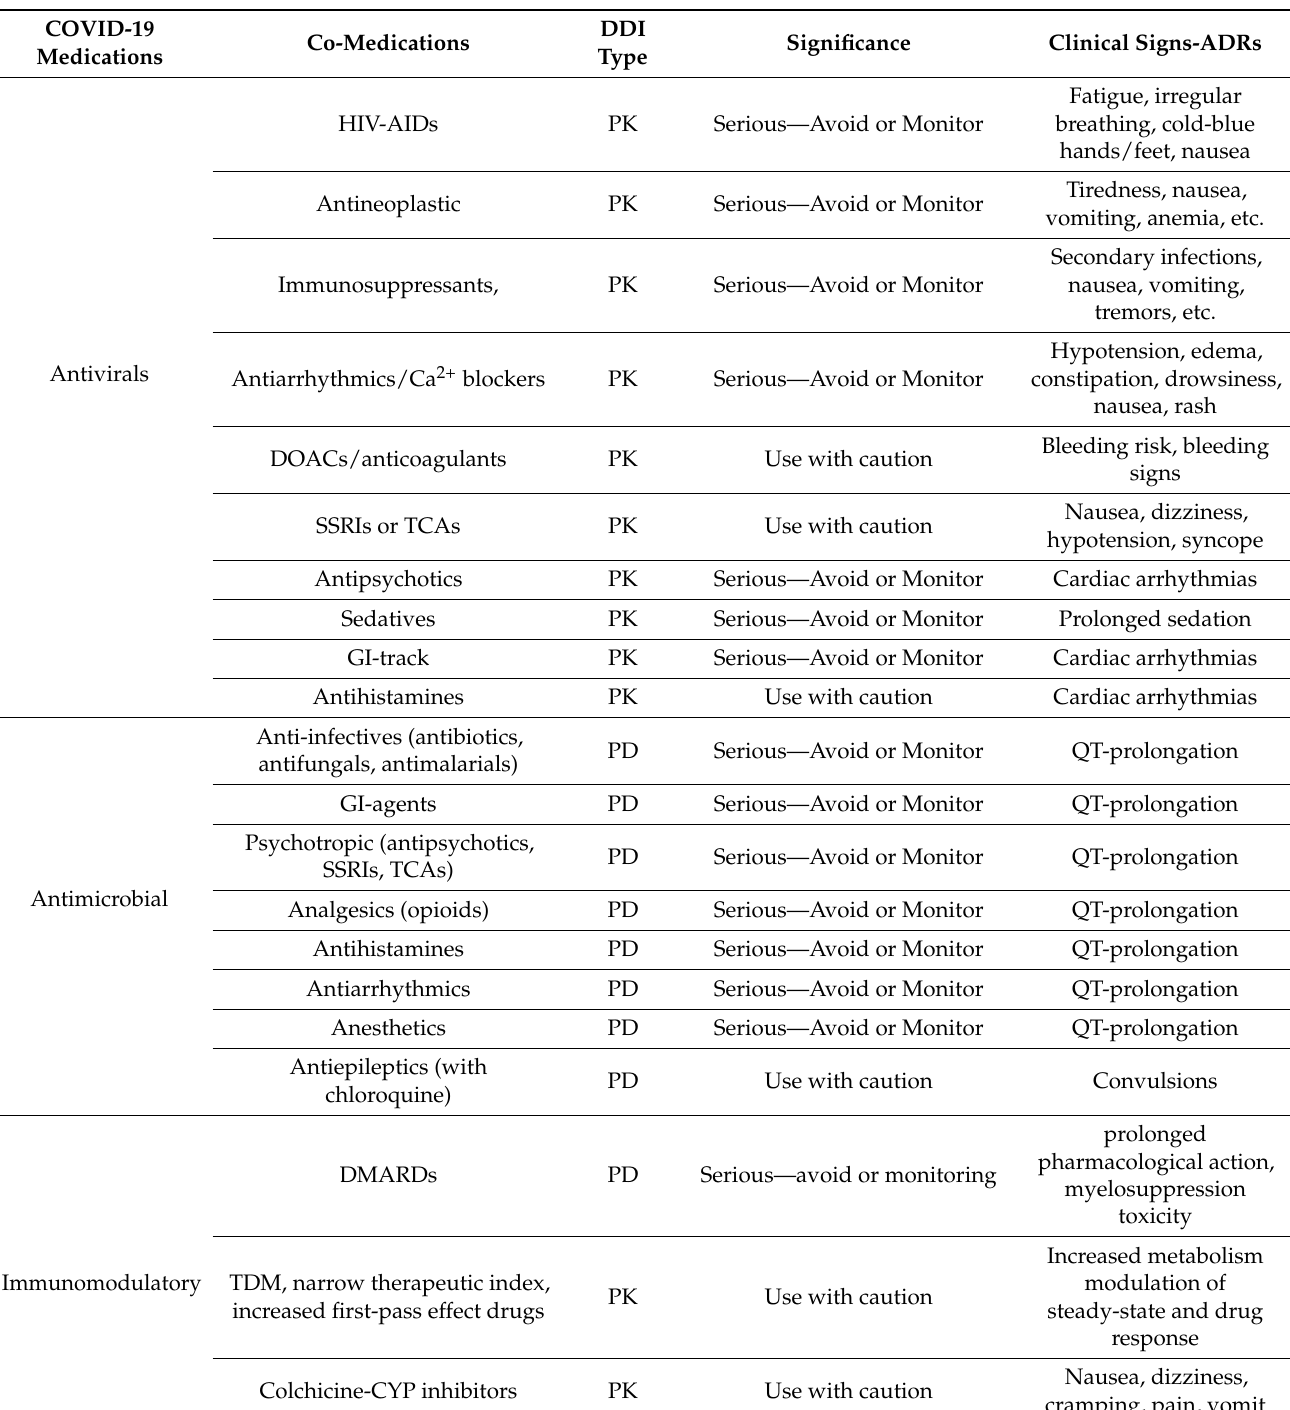
Table 2. Potential DDIs in COVID-19 medications, their clinical significance, and clinical signs of ADRs related with them. (PK, pharmacokinetics, i.e., transport and metabolism processes; PD, pharmacodynamic, i.e., potassium Ccannels in heart, convulsion thresholds).